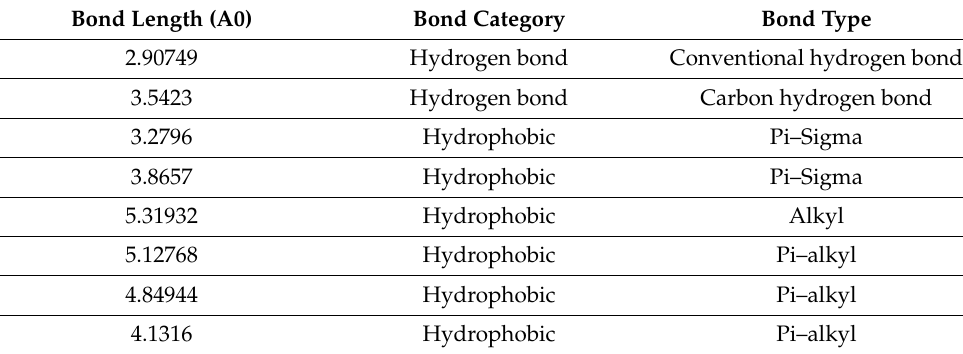
Table 5. The active residues, bond length (A0), bond types, and bond categories involved in the molecular interactions of curcumin with NLC in a complex.